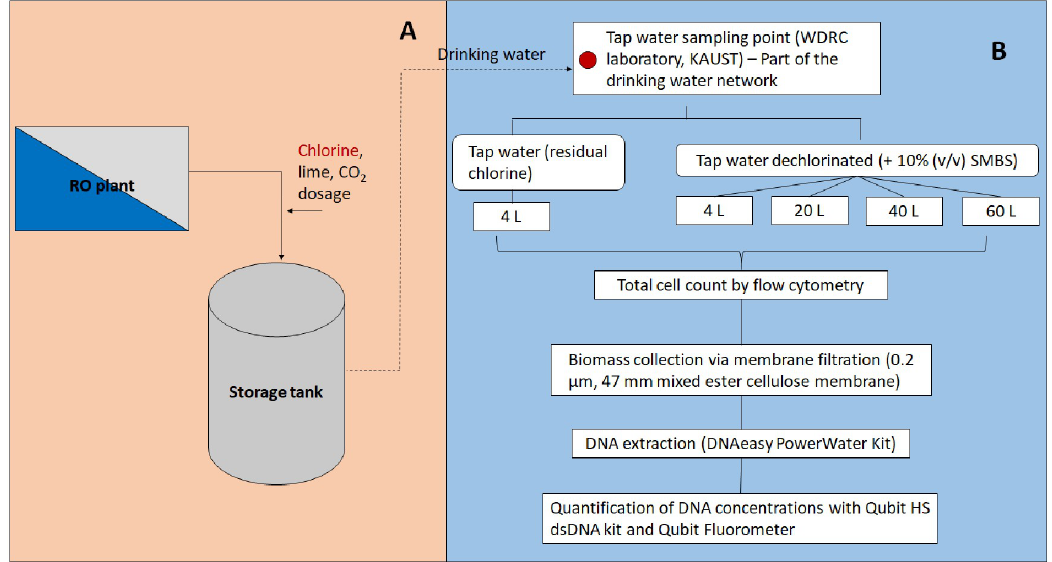
Fig 1. The upstream part of KAUST seawater reverse osmosis plant (A) and the schematic overview of the DNA recovery evaluation with different filtration volumes from tap (drinking) water in this study (B). A 10% (v/v) solution of sodium metabisulfite (SMBS) (Na 2 S 2 O 5 ) was used to quench the free chlorine (referred as